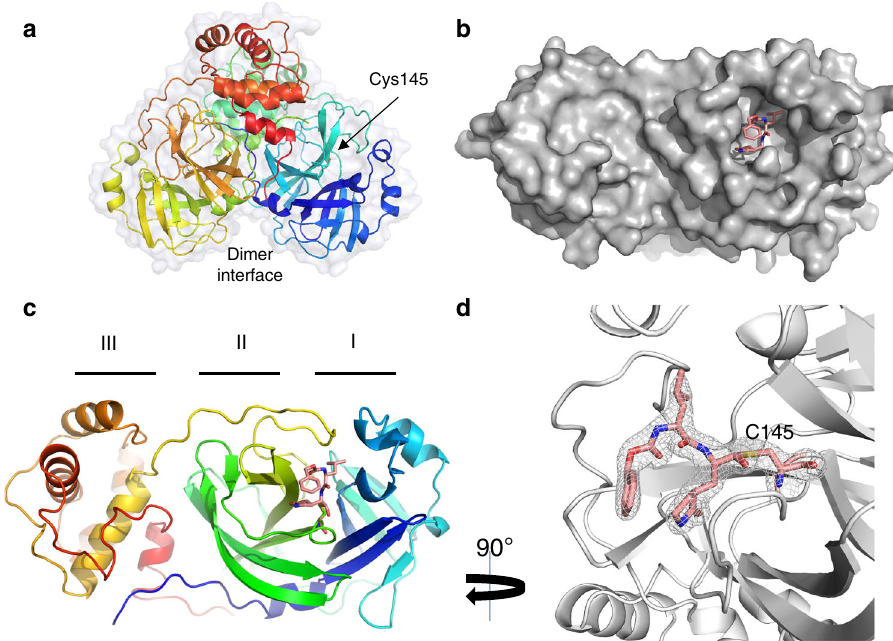
Fig. 2 The crystal structure of SARS-CoV-2 M pro in complex with GC373 (converted from GC376). a Apo-SARS-CoV-2 M pro forms a dimer (6WTM. pdb). b Prodrug GC376, when incubated with SARS-CoV-2 M pro , converts to GC373 which forms a covalent bond with C145. Surface representation reveals the active site pocket in complex with GC373 (6WTJ.pdb). c Ribbon representation of one SARS-CoV-2 protomer in complex with inhibitor